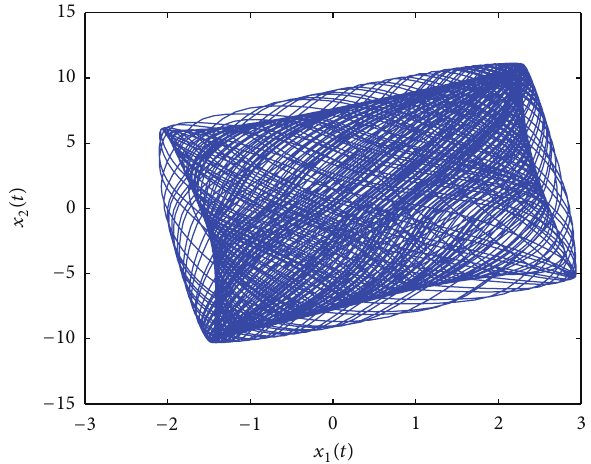
Figure 4: Trajectory of the synchronized state of system